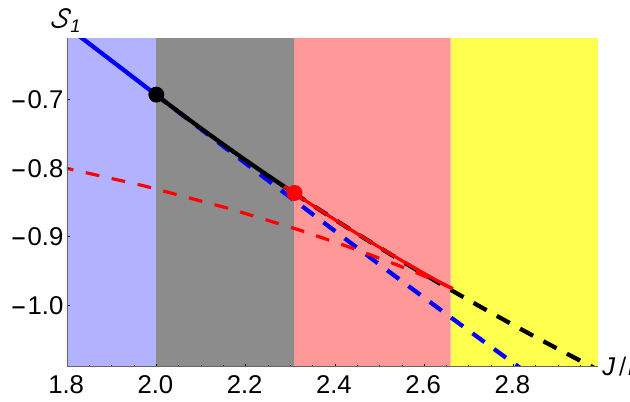
Figure 4 . Phase diagram depicting the entropy S 1 of the di(cid:11)erent con(cid:12)gurations close to the (cid:12)rst black bar zero-mode, as a function of angular momentum. For J=M > 2 the black bar (black) is entropically favored over the MP black hole (blue). At the zero-mode J=M = 4 = stable dumbbells (red) appears with S inv slightly higher than that of unperturbed black bars. This phase dominates entropically up to the turning point at ( J=M ) c (cid:25) 2 : 66, where stable dumbbells cease to exist, and the system typically evolves to a